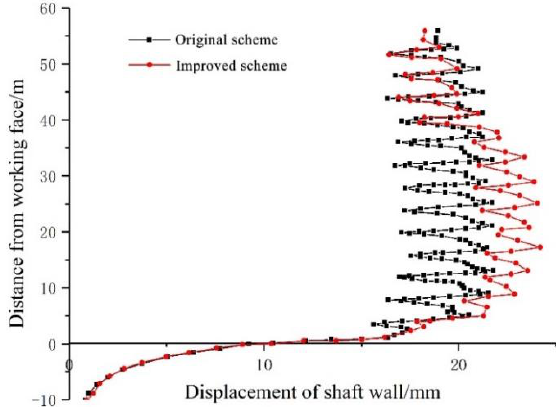
Figure 15. Longitudinal deformation profile of the shaft.